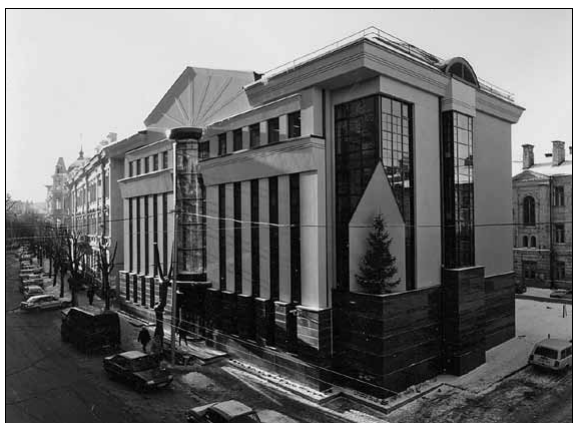
fig. 2. Hermis Bank in Vilnius, by architects Pempė and ramunis,